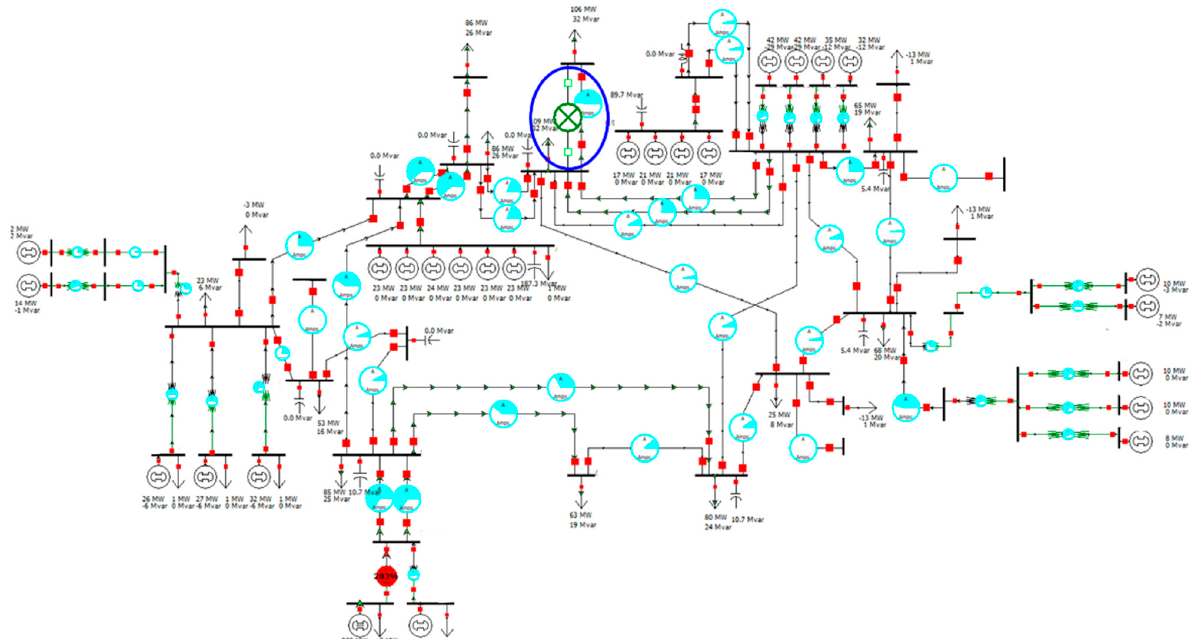
Figure 7. Systematic diagram for N-1 contingency analysis (CASE 1); blue line circle refers to the broken line for contingency analysis.